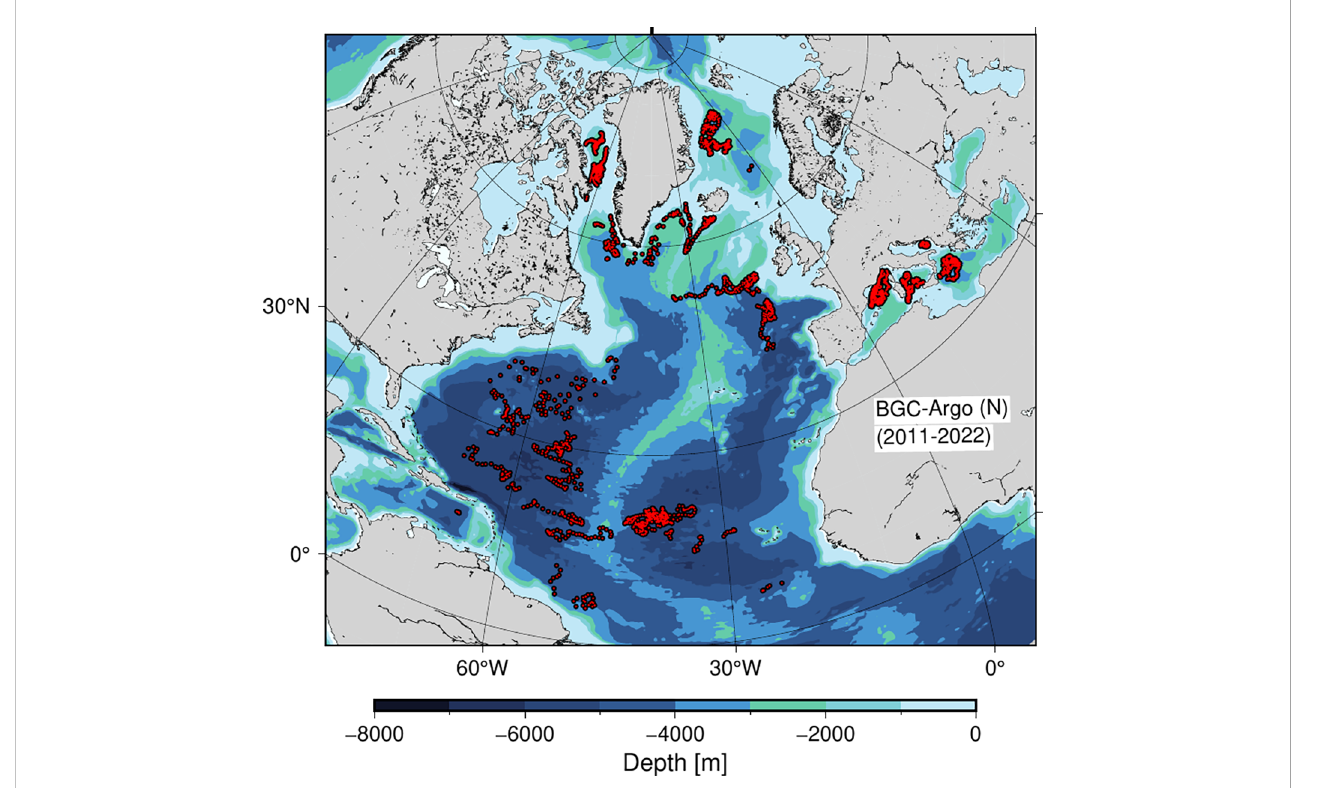
FIGURE 1 BGC-Argo pro fi les (red bullets) in the North Atlantic containing nitrate pro fi les (N) between